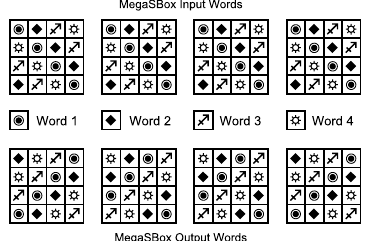
Figure 5: AESQ as an S ◦ L ◦ S construc- 2 → 9 tion.